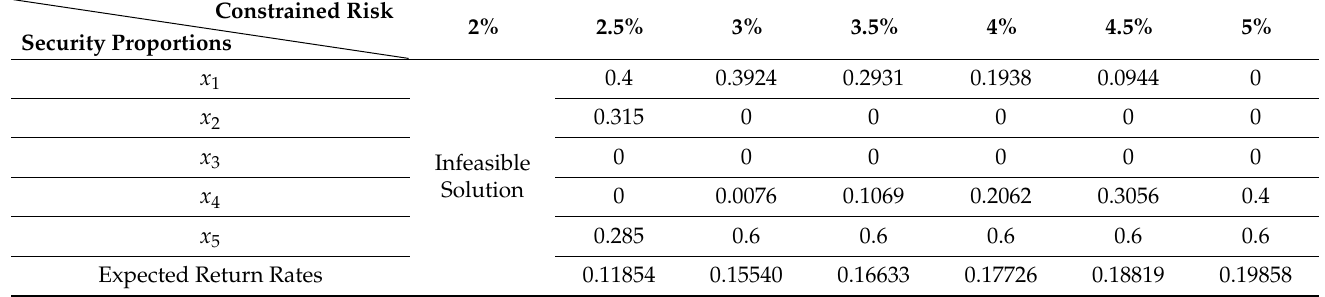
Table 9. The dimension with t = 2 and s = 2 with a guaranteed return rate (cid:101) p 3 in the proposed model.